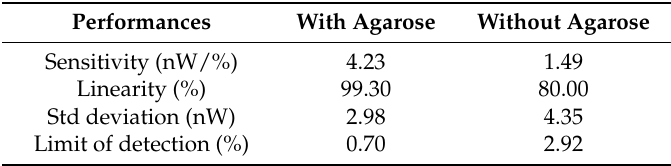
Figure 3. The humidity response of the proposed sensor with and without the agarose gel. Table 1. Performance of the proposed